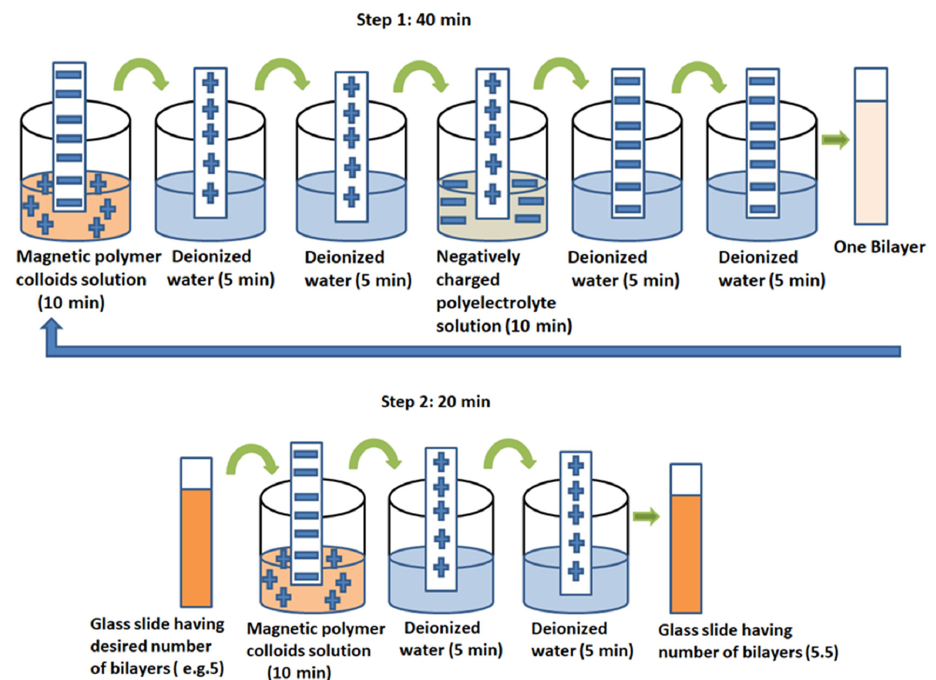
Figure 2. Schematic representation of fabrication of thin films using layer-by-layer technique.